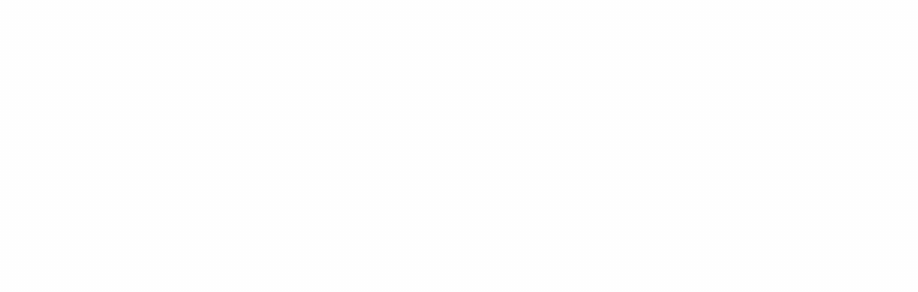
Fig. 3: Summary of differential effects across tasks and conditions. The spatial distribution of significance is shown in the top row, where gray-scale coding symbolizes the number of channels and time points (within a given interval) for which w,(t) < 0.01 holds. The number of subjects (out of 8) is given in which each differential effect is observable. V: the same effects are observed in both choice versus color and height versus color comparisons. T: the same effect is observed in the choice versus color